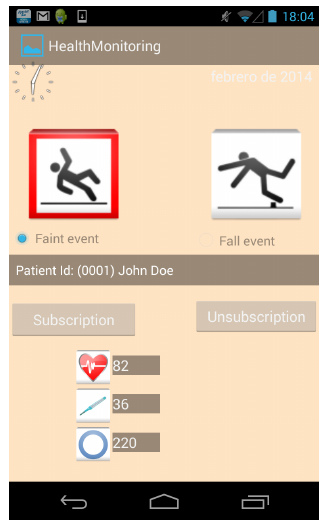
Snapshot of the management application for the medical staff running on Android